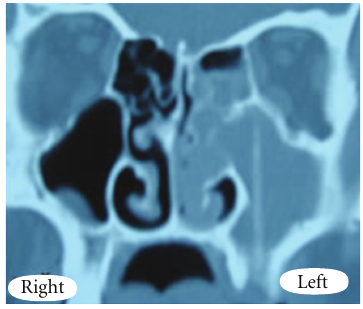
Figure 1: CT scan showing the foreign body in the left maxillary sinus.